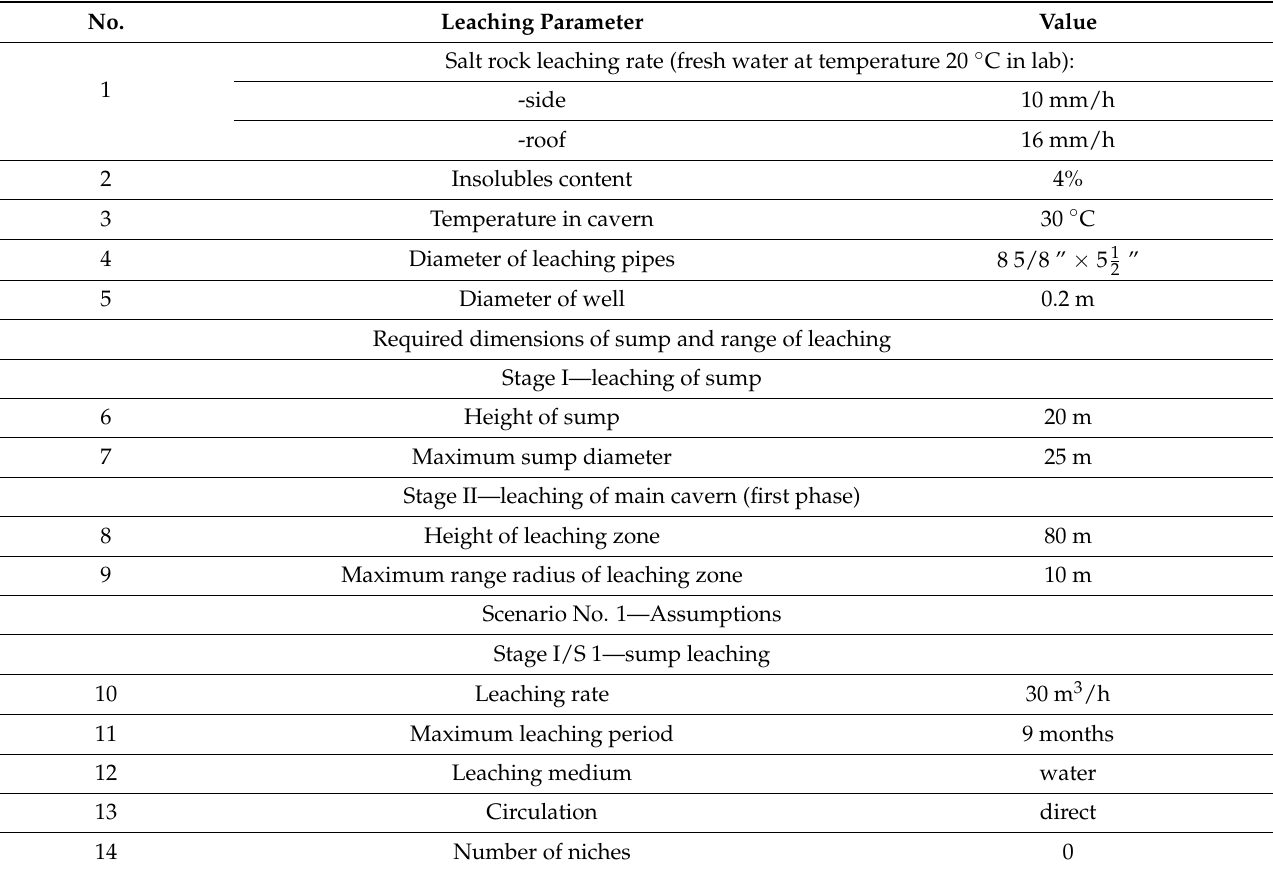
Table 2. Leaching parameters adopted in the